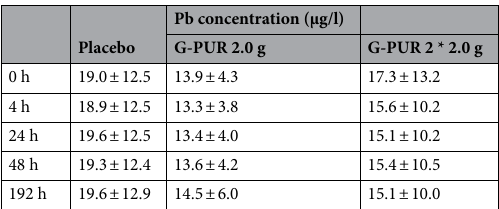
Table 3. Whole blood Pb concentrations by treatment groups over time. Data are means ± SD ( n = 14 per group).